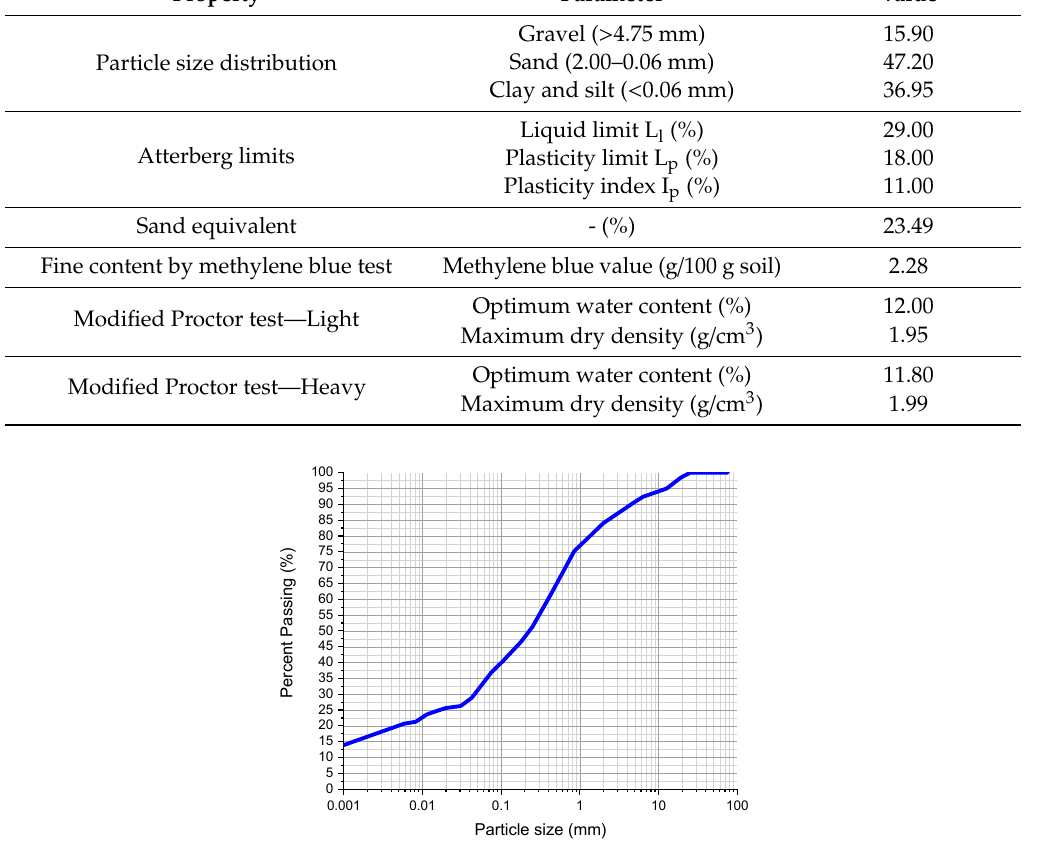
Table 1. Particle size distribution and Atterberg limits of the soil used.